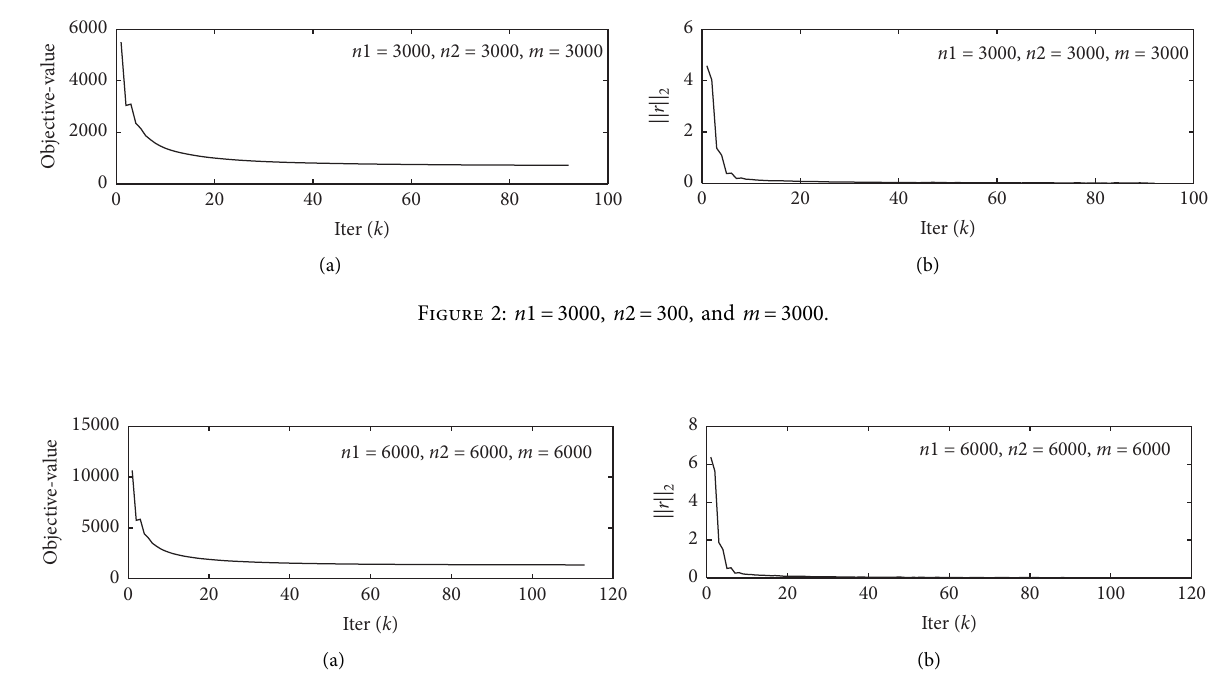
Figure 3: n 1 � 6000, n 2 � 6000, and m �